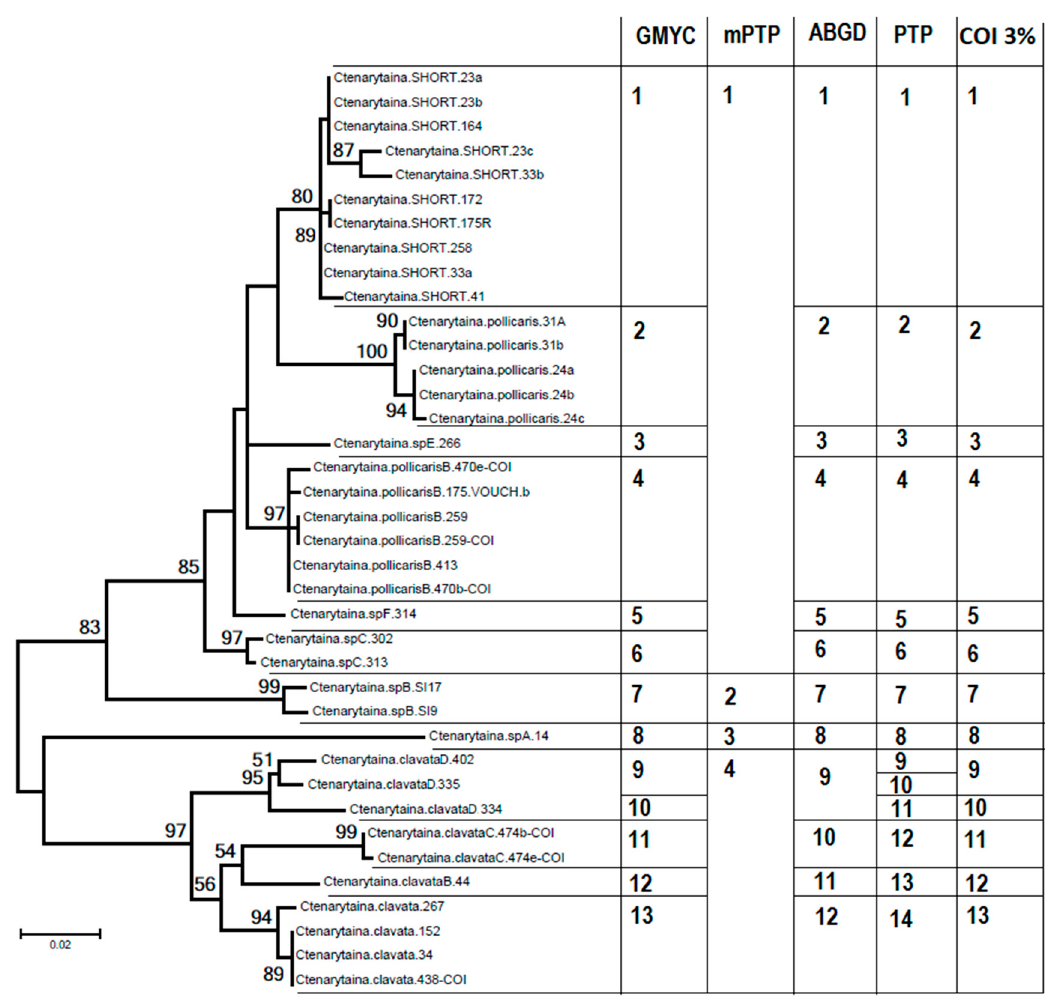
Figure 1. A COI gene tree (Kimura 2–Parameters model, Maximum Likelihood algorithm, 10,000 replicates, bootstraps <50% not reported) showing relationships between all Ctenarytaina samples collected from m ā nuka, k ā nuka and Olearia . The numbers on the right represent the taxa predicted by each of the species delimitation methods, GMYC, mPTP, ABGD, PTP and ≥ 3% COI divergence. The tree nodes are supported by bootstrap values. The bar represents a genetic distance of 0.02.